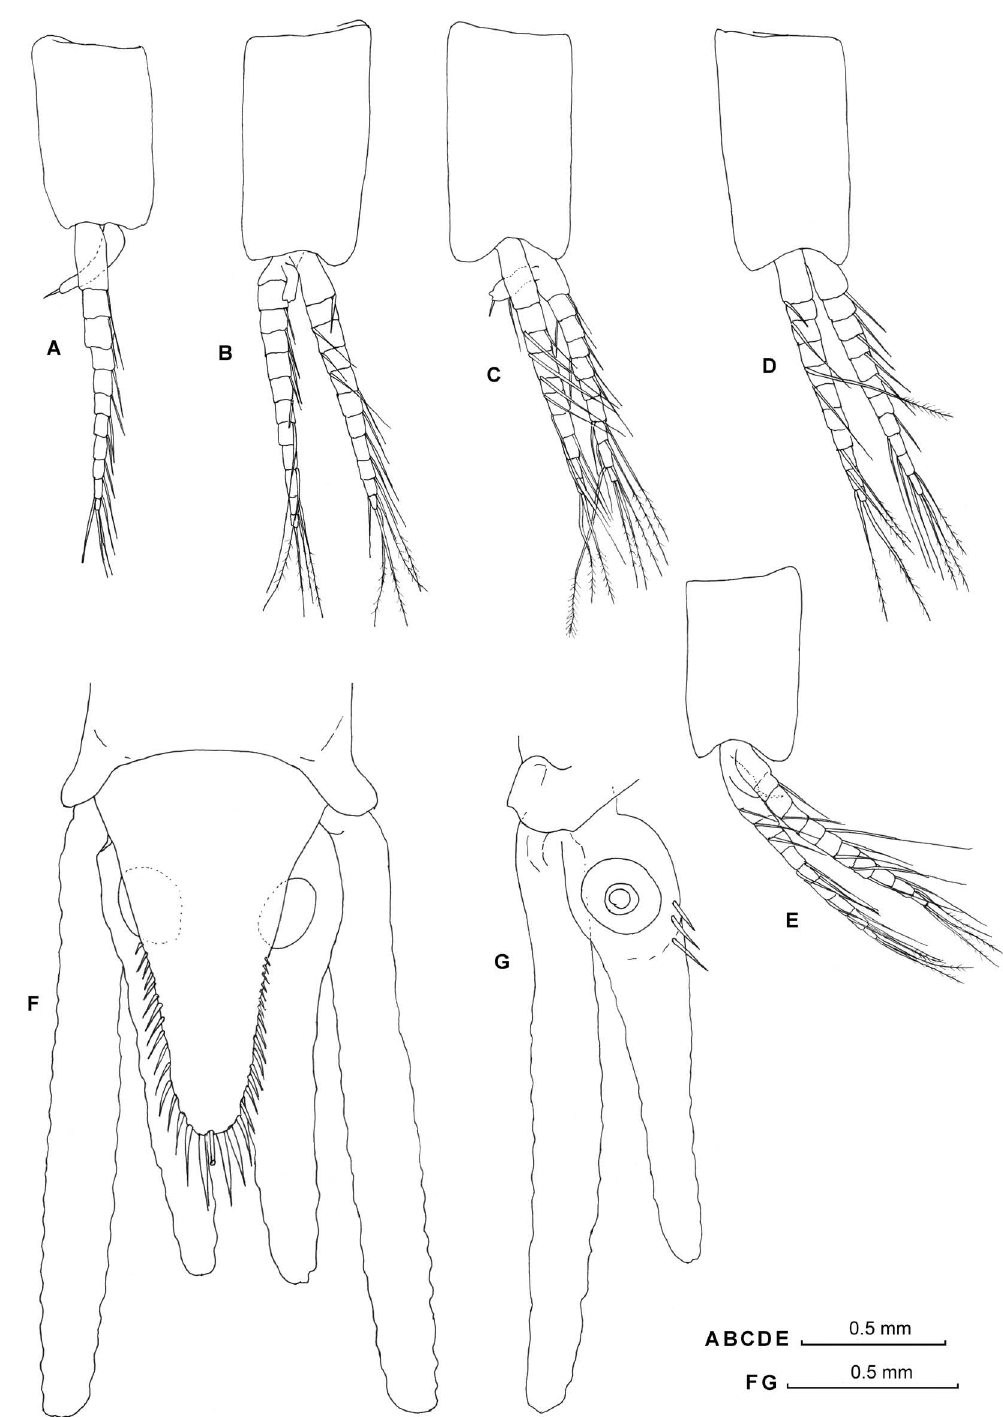
Fig . 4. – Dactylamblyops corberai n. sp.; holotype, mature male: A, 1st pleopod; B, 2nd pleopod; C, 3rd pleopod; D, 4th pleopod; E, 5th pleopod; F, uropods and telson in dorsal view; G, uropod in ventral